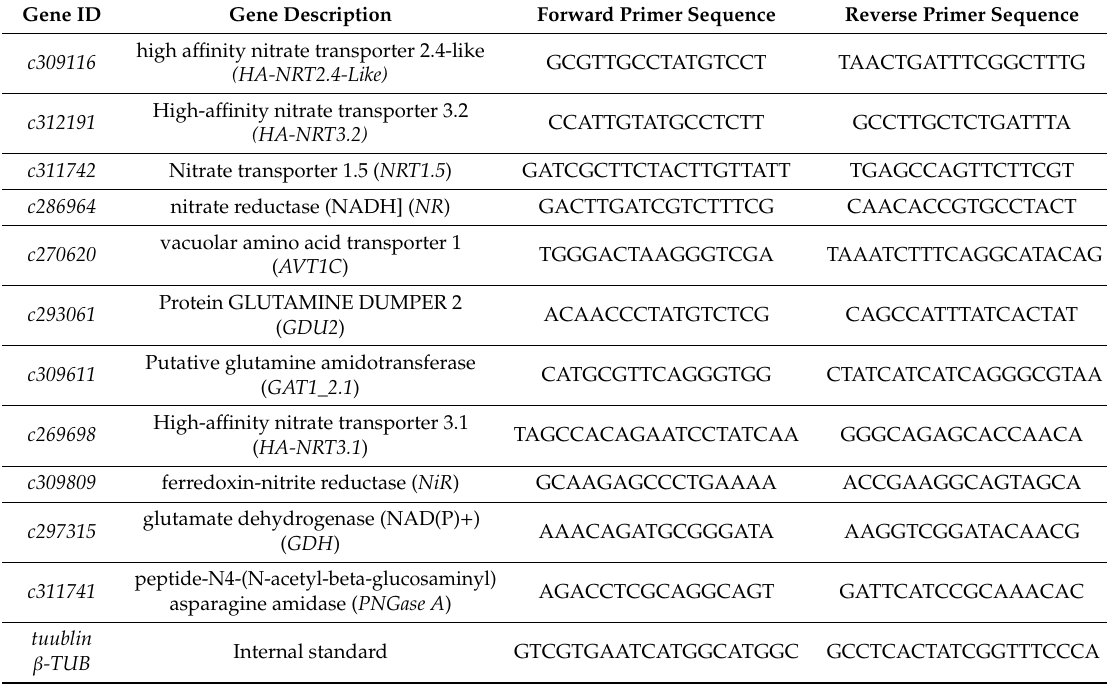
Table 4. Primers used for qRT-PCR analysis of selected genes.